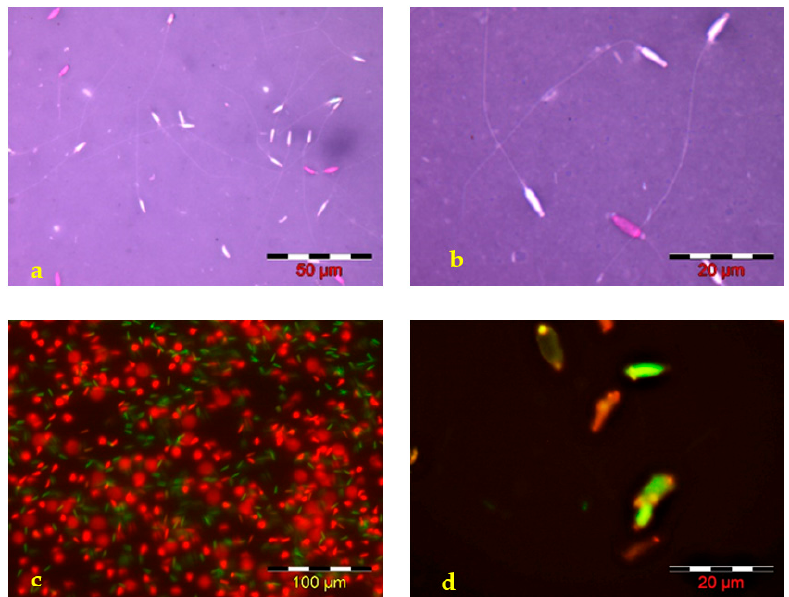
Figure 2. Microscopic images—Russian sturgeon sperm smears stained with ( a , b ) Eosin-Nigrosin (spermatozoa with an affected membrane stained in pink and spermatozoa with complete mem- brane integrity—not stained) and ( c , d ) with SYBR 14—PI end examined in fluorescence micros- copy— dead sperm cells, live sperm cells.